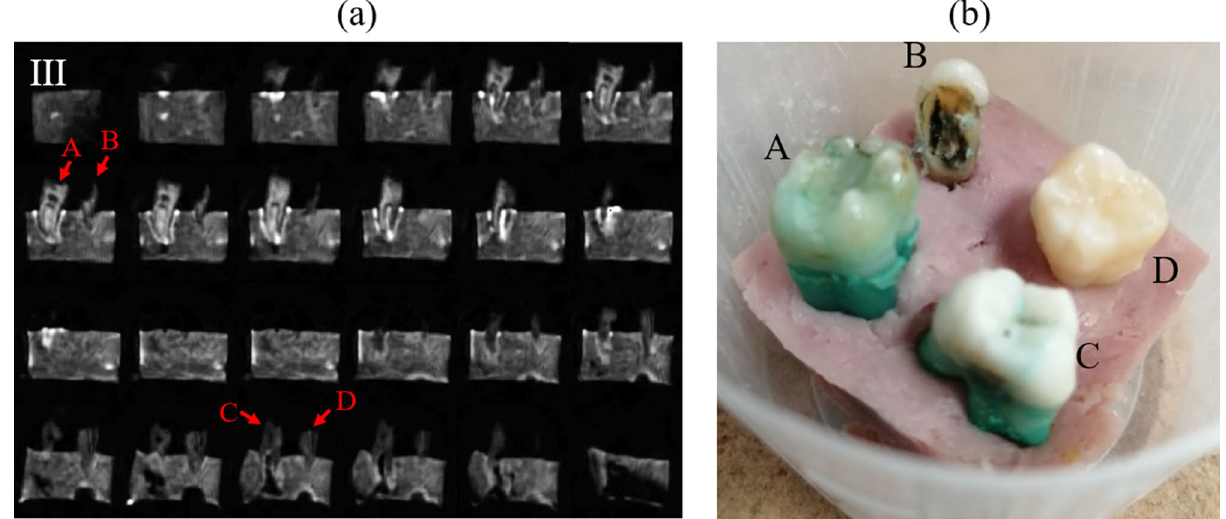
Figure 3. ( a ) 2 dimensional slices of four human teeth embedded in a piece of pork ham (PETRA). ( b ) Photograph of the